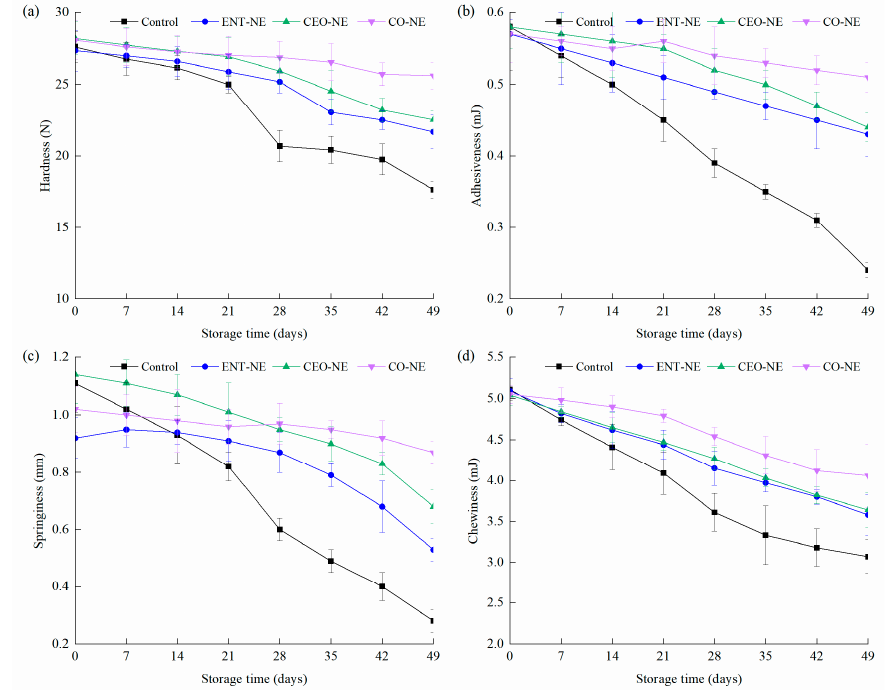
Values are expressed as means ± standard deviation. Columns with no uppercase letters in common for each storage time are significantly different and rows with no lowercase letter in common for each treatment are significantly different ( p < 0.05).